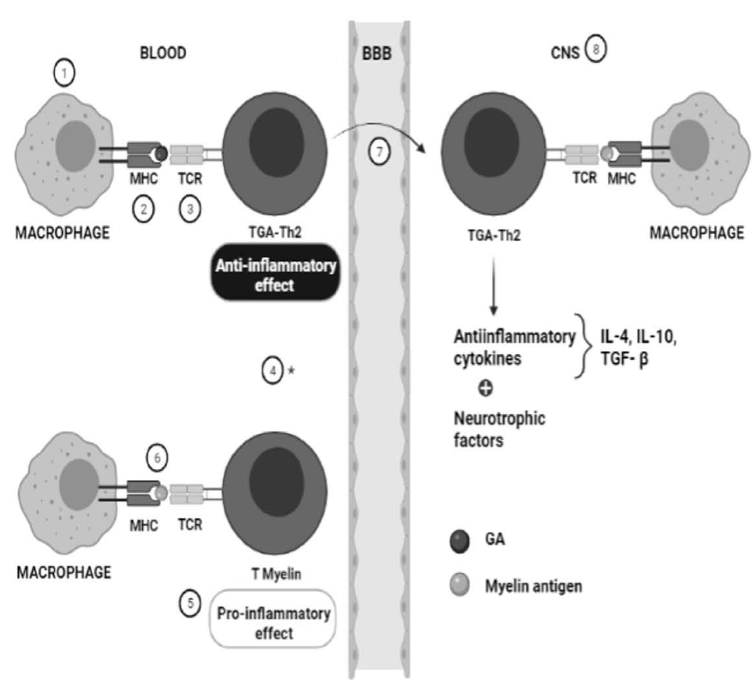
Figure 1. Mechanism of action of GA in treatment of multiple sclerosis. GA modulates the immune response and alters T-cell differentiation by competing with MBP in the major histocompatibility complex responsible for antigen presentation. Numbers represent the action site of genes with probable potential involvement in the pharmacokinetics and pharmacodynamics of GA therapy, patho-etiology of MS, apoptosis and neuroprotection, and CNS repair. 1. APCs: CD86, CCR5, CLEC16A; 2. MHC: HLA-DRB1, CTSS; 3. TCR: TRBC1; 4. T-cell regulation: EOMES, PVT1, CCR5, PTPRT, UVRAG; 5. Pro-inflammatory pathway: ALOX5AP, IL12RB2, IL22RA2, IL1RL1; 6. MPB: MPB, CTSS; 7. T-cell migration: CCR5; 8. CNS: MAGI2, RFLP3, SLAC1A4; * Other: Apoptosis mediatiors: CD95, ZAK. APC: antigen-presenting cells; BBB: blood– brain barrier; CNS: central nervous system. Table 1. Influence of gene polymorphisms on glatiramer acetate therapy in Caucasian patients with multiple sclerosis.